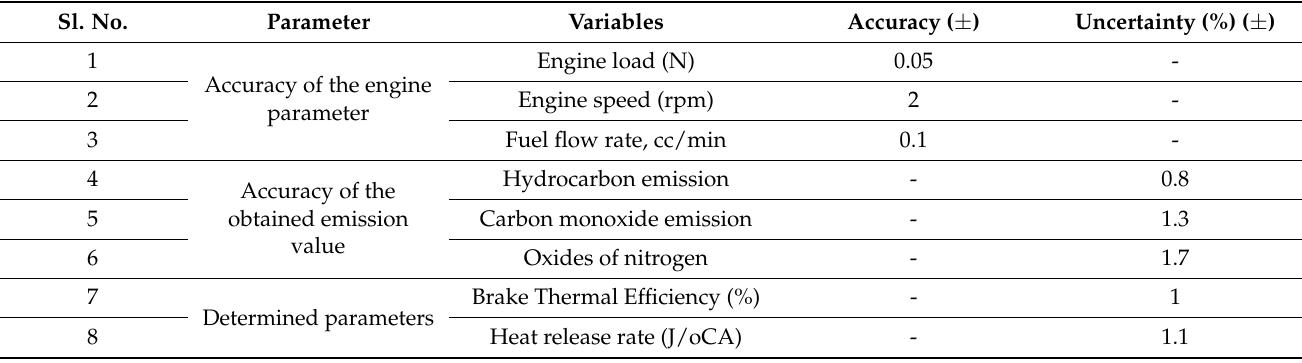
Table 5. Measurement accuracy and uncertainty analysis.